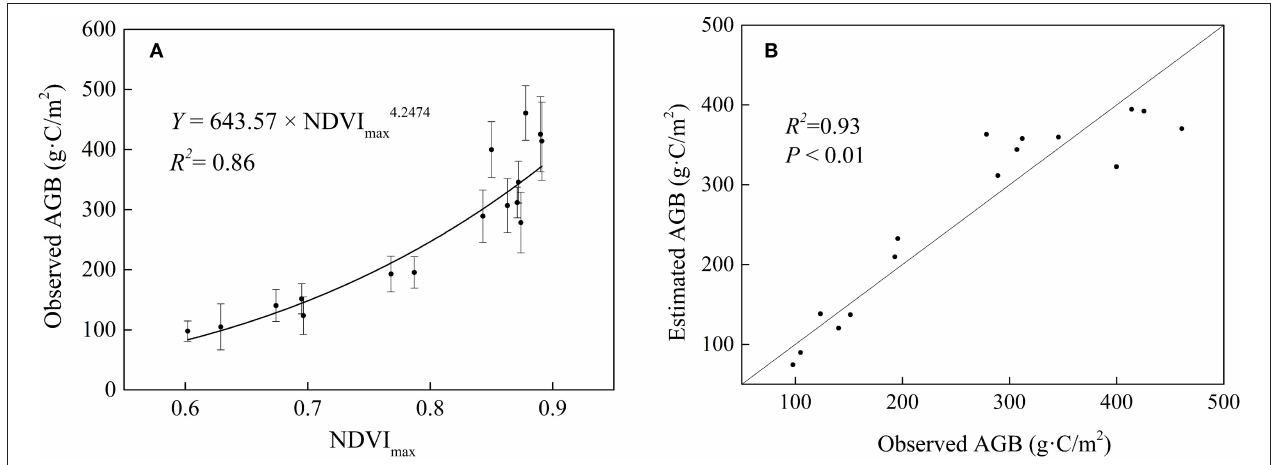
FIGURE 2 | Equation between maximum normalized difference vegetation index (NDVI max ) and observed AGB density (A) , and comparison between estimated AGB density and observed AGB density (B) in the marsh of the Sanjiang